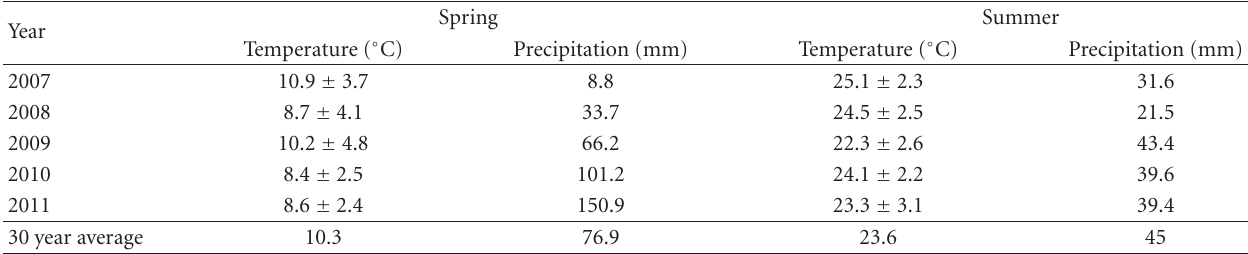
Table 1: Spring (March to May) and summer (June to August) mean temperature ( ± SD) and total precipitation in western Utah, USA, 2007–2011 where we evaluated mule deer use of water